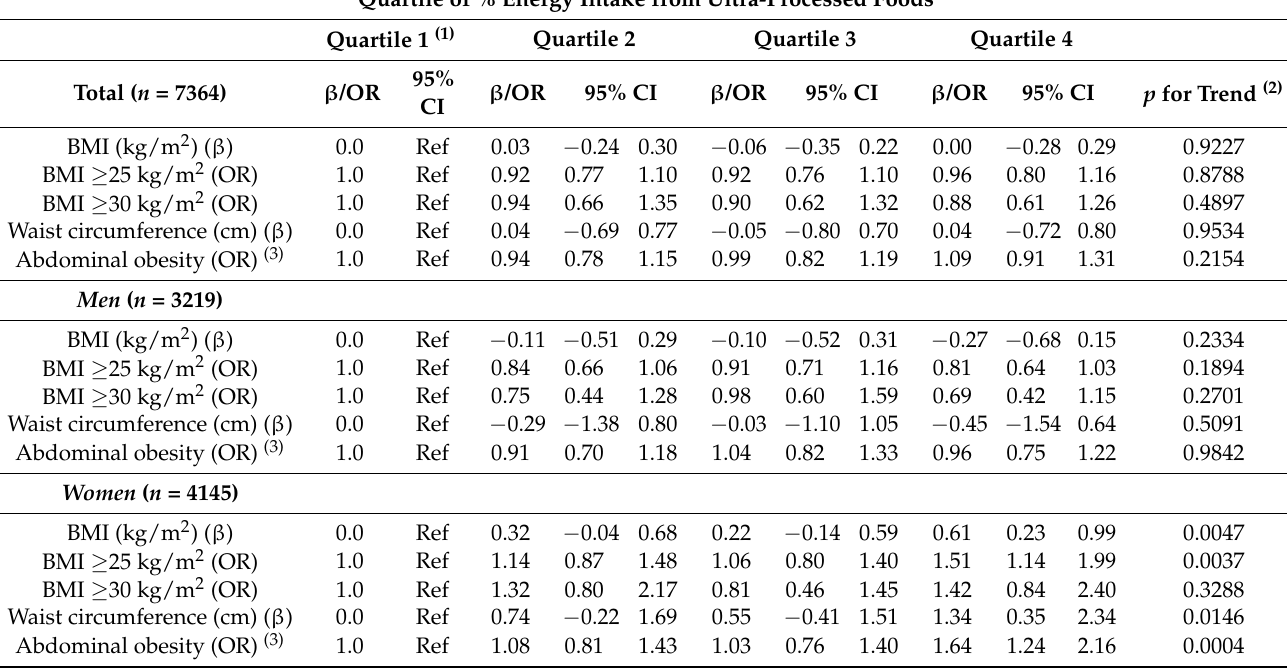
Table 4. Odds ratio and confidence intervals/regression coefficient for obesity according to quartiles of relative energy intake from ultra-processed foods among Korean